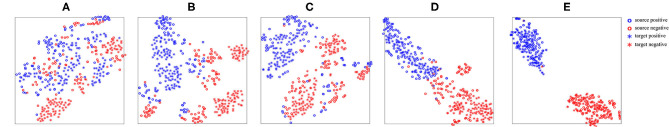
Feature visualization diagram. (A) original distribution of the features of the source and target domains; (B) distribution of the features after being mapped by the TCA algorithm; (C) distribution of the features learned by the DANN algorithm; (D) distribution of the features learned by the MMD algorithm; (E) feature distribution of TDANN learning.